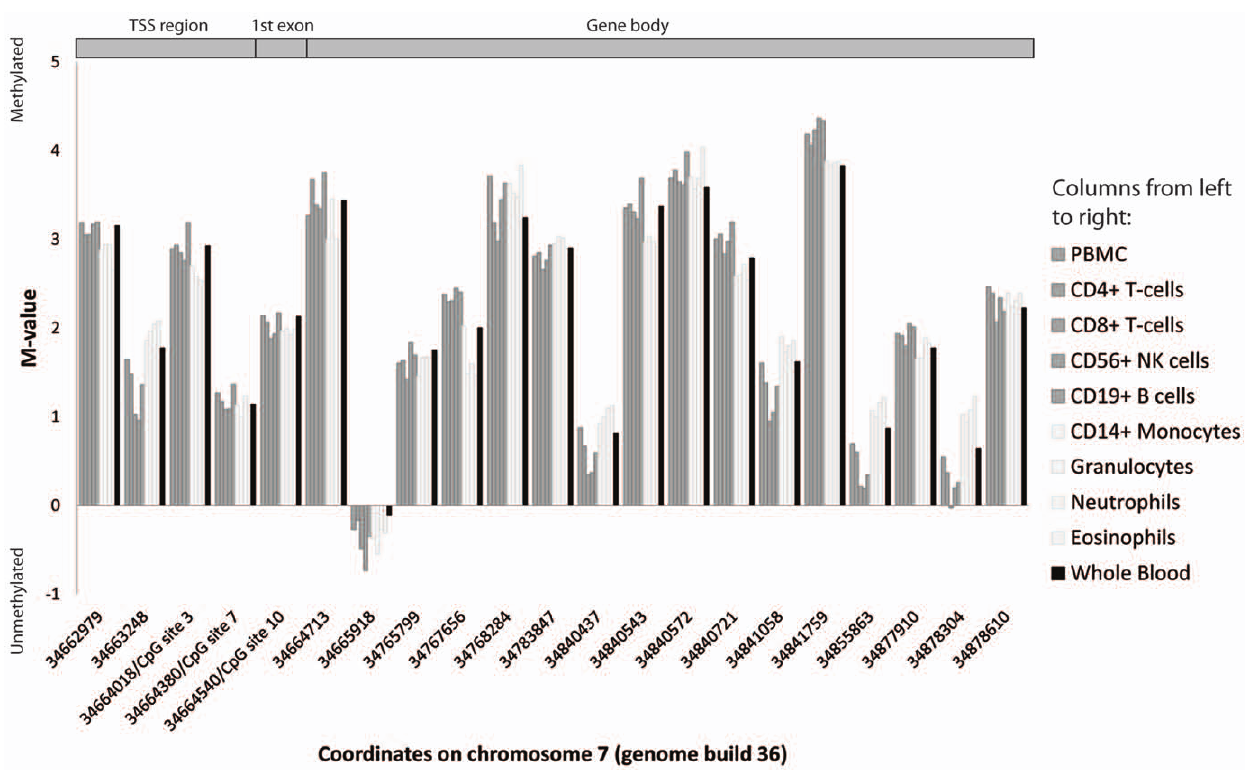
Figure 3. Neuropeptide S Receptor 1 gene ( NPSR1 ) DNA methylation levels in isolated cells from peripheral blood. Peripheral blood donations were obtained from six healthy adult male donors. Data were obtained using the Illumina Infinium 450K bead array and the M-value represents methylation degree [25]. Dark grey bars represent lymphoid cells, light grey bars myeloid cells and black bar whole blood. TSS – Transcription start site.